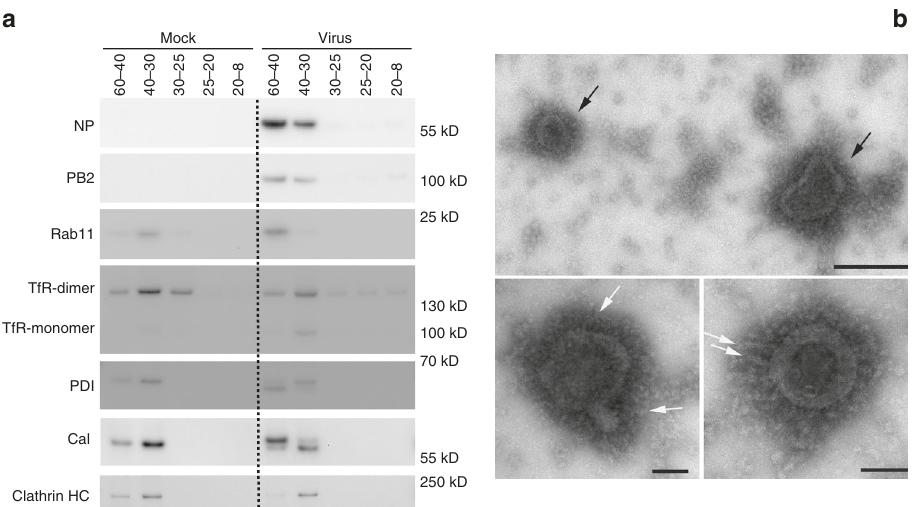
Fig. 9 Characterization of puri fi ed ICVs. A549 cells were infected with the WSN virus and submitted to subcellular fractionation at 14 hpi. a Western-blot analysis of subcellular fractions of mock-infected (left panel) and IAV-infected (right panel) A549 cells, upon sucrose gradient ultracentrifugation. The same amount of total protein was analyzed for each fraction. TfR: transferrin receptor; PDI: protein disul fi de isomerase; Cal: calreticulin; Clathrin HC: Clathrin Heavy Chain. For gel source data, Supplementary Fig. 17. b TEM analysis of an aliquot of fraction 60 – 40% from IAV-infected cells, upon fi xation and negative staining. Black arrows: ICVs. White arrows: vRNPs. Scale bar: large panel 200 nm, small pannel 100 nm